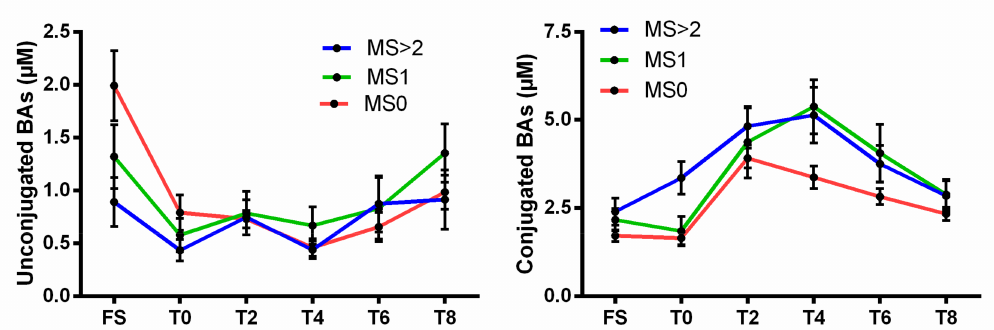
Figure 6. Circulating levels of unconjugated and conjugated BAs according to postprandial time course in subjects stratified according the number of co-existing criteria of the metabolic syndrome (MS). MS0: patients without out any MS component (n = 45); MS1: patients with 1 MS component (n = 16); MS > 2: patients with at least 2 MS components (n = 10). Values are mean ±